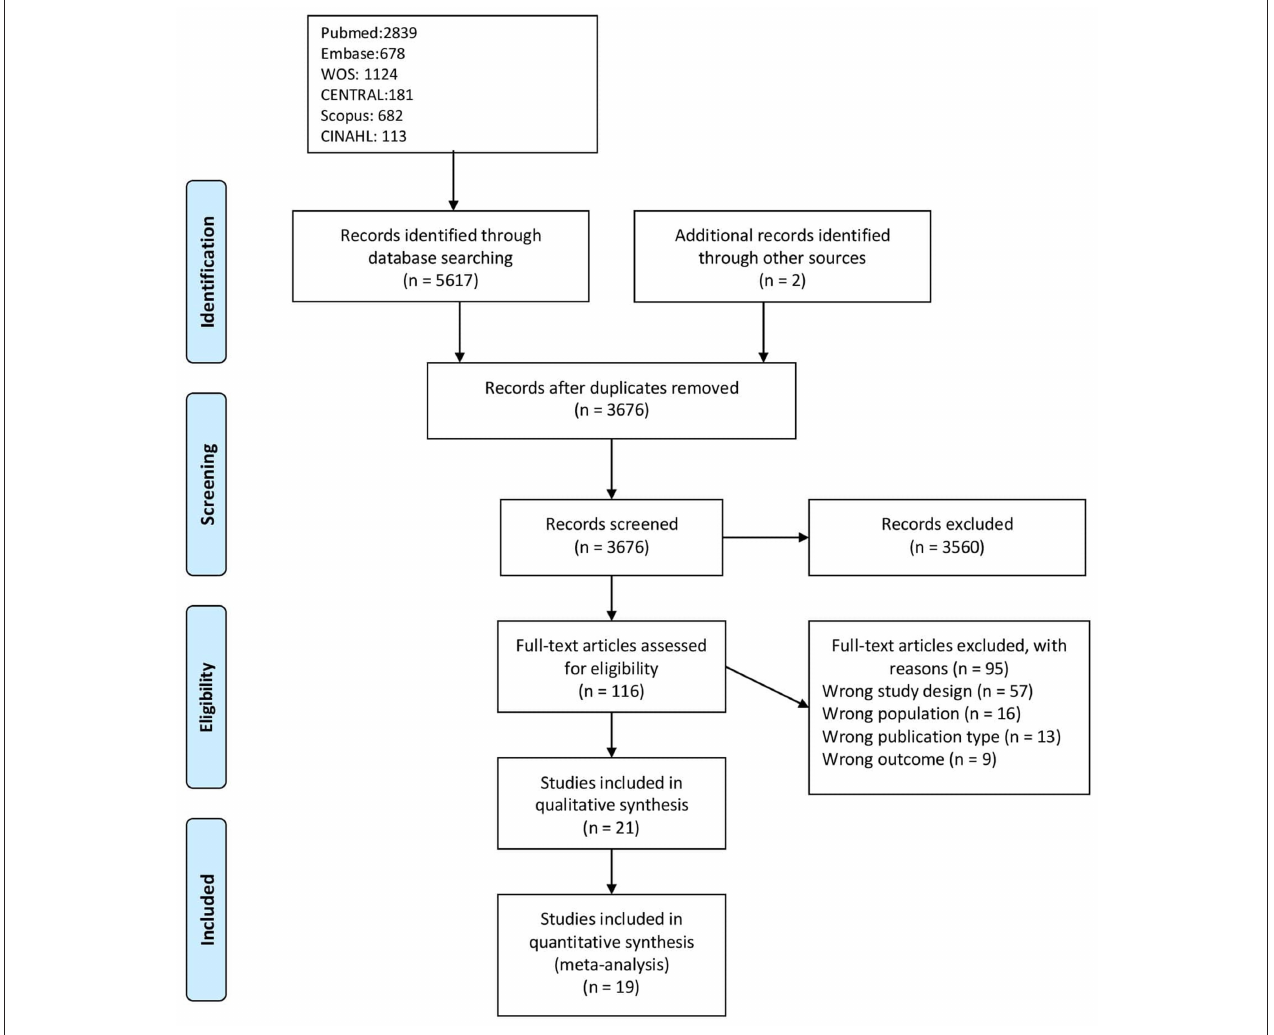
FIGURE 1 | PRISMA flowchart of the